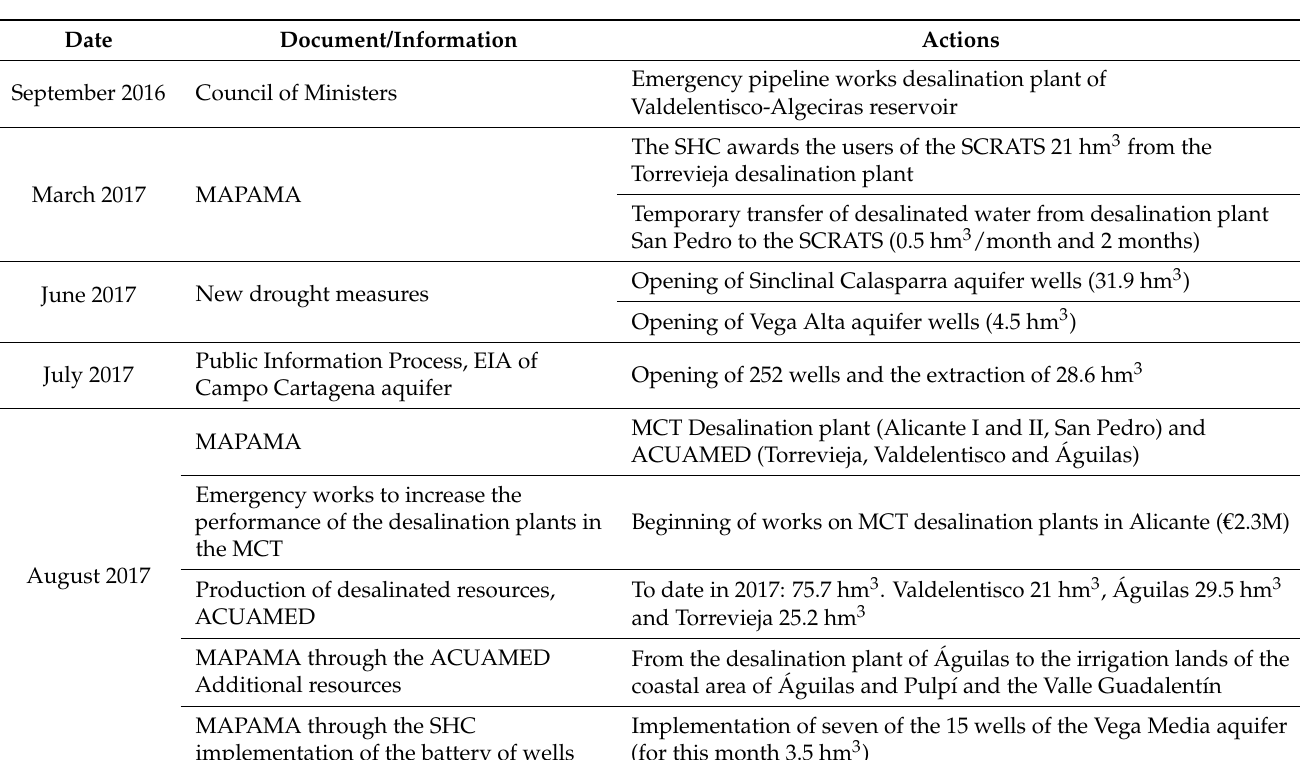
Table 15. Actions carried out in the area of the SRB during the water year 2016/17. Source: own elaboration based on